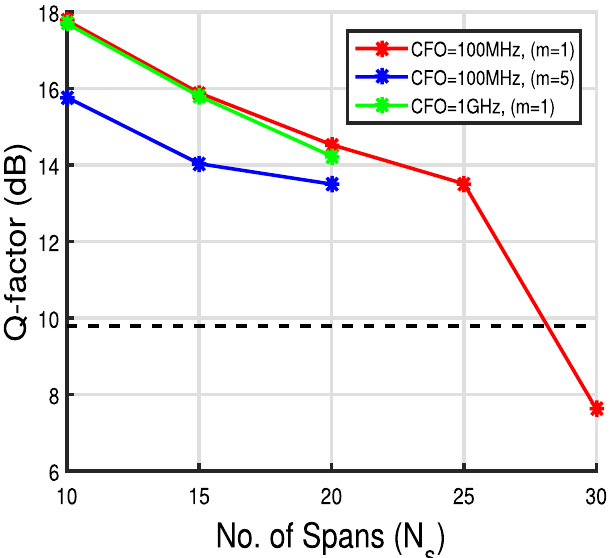
100 kHz and launch power of 1 dBm. =